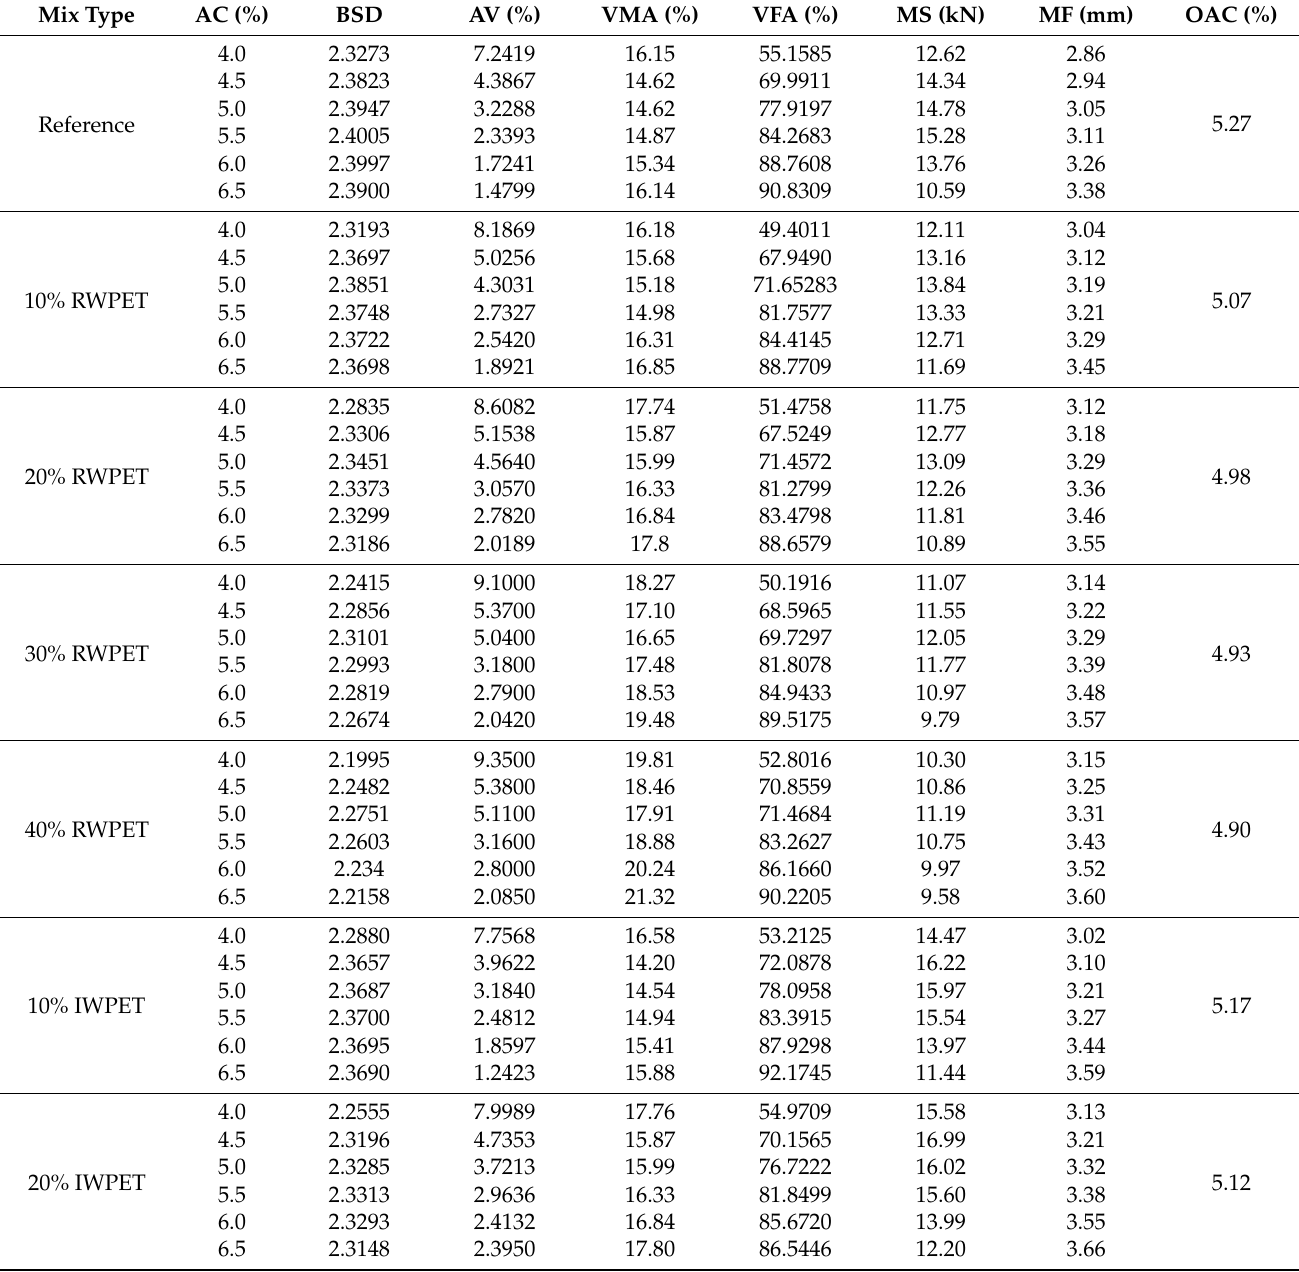
Table 3. Marshall Mix design results for the matrix